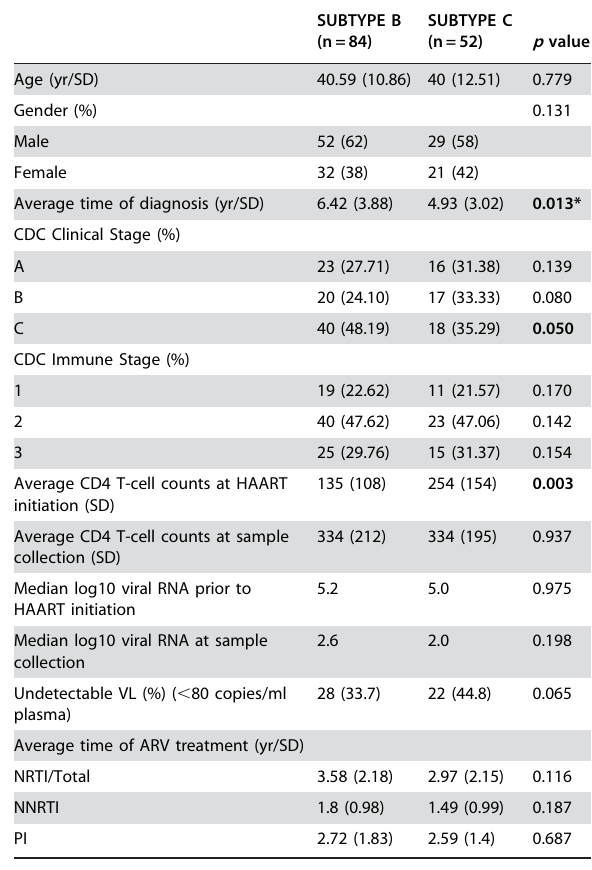
Table 1. Demographic and clinical characteristics of HIV-1- positive treated patient groups infected with B and